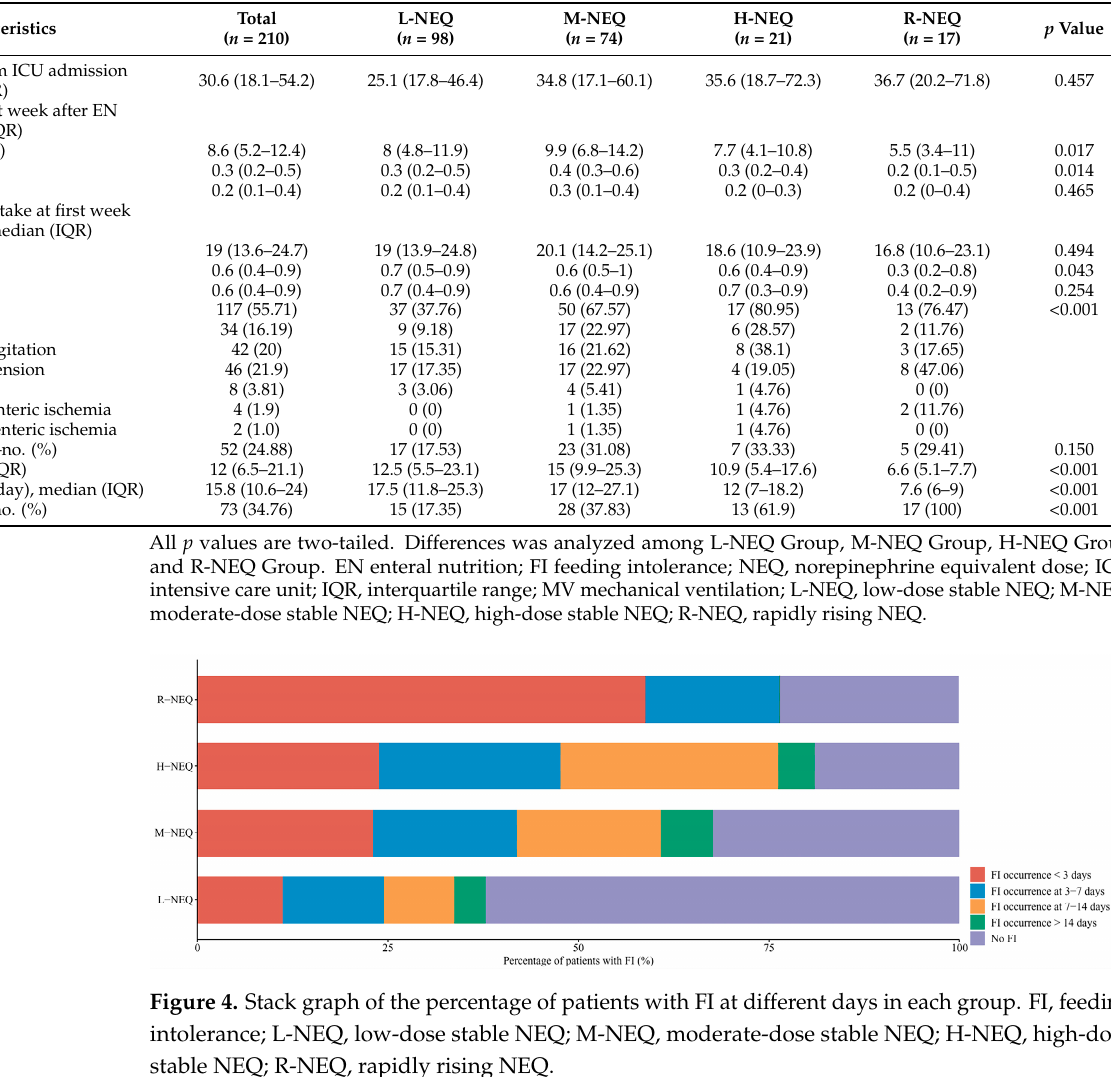
Table 2. Clinical outcomes in patients with shock by NEQ Trajectory Groups.